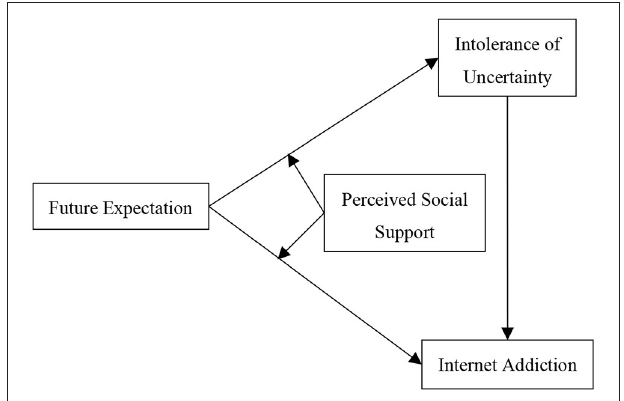
FIGURE 1 | The proposed moderated mediation